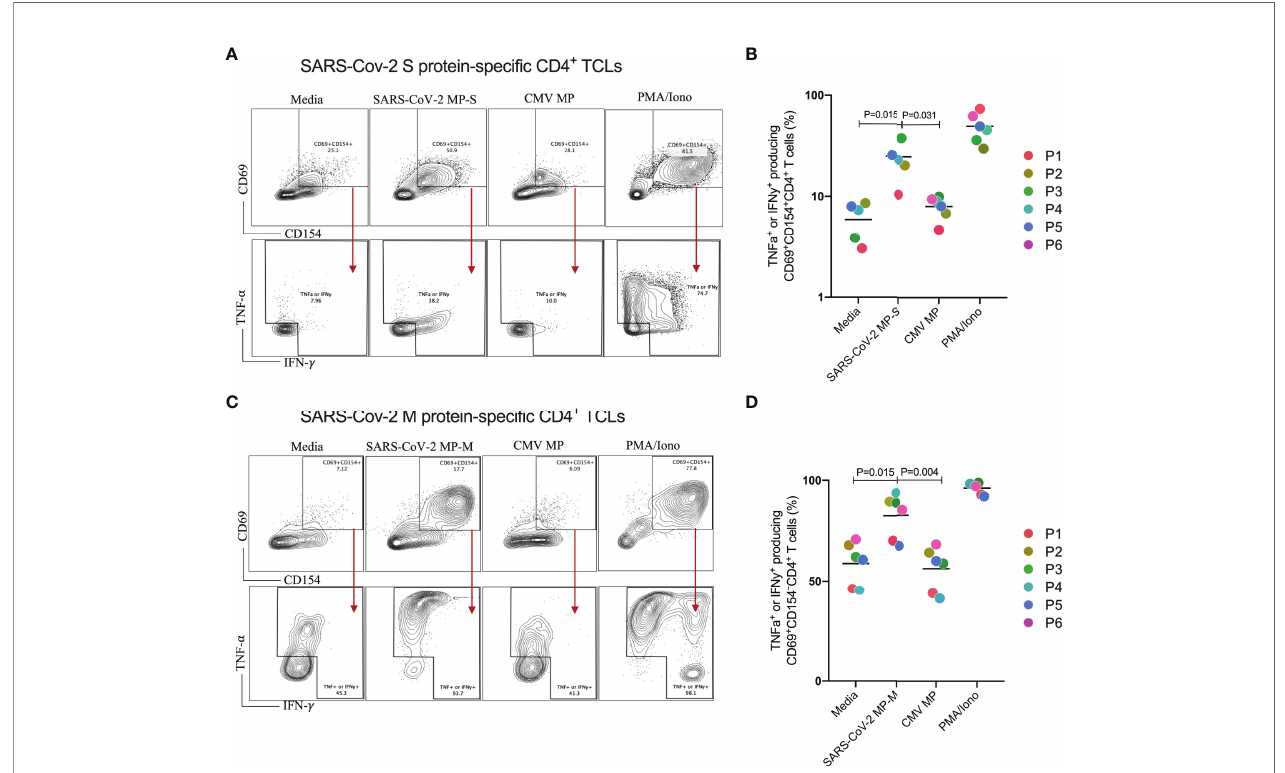
FIGURE 2 | Pro fi ling of SARS-CoV-2 spike (S) and membrane (M) proteins-speci fi c CD4+ T cell line for antigen speci fi city. SARS-Cov-2 spike protein-speci fi c CD4 + TCLs from 6 different donors were cultured in vitro in the absence (media) or in the presence of different stimulation conditions including: either SARS-Cov-2 MP-S (1 µg/mL) or MP- M (1 µg/mL); CMV MP-M (1µg/mL), and PMA/ionomycin (0.5/0.05pg/mL). Panels (A – C) show a representative fl ow cytometric analysis of the of both MP-S or MP-M-speci fi c CD4 + TCLs expressing CD69 + CD154 + and the subsequent antigen-speci fi c cells expressing either IFN- g + or TNF- a + after the different stimulation conditions. Panels B and D reveal the speci fi city and the reactivity of the six MP-S speci fi c CD4 + TCLs (B) or the six MP-M speci fi c CD4 + TCLs (D) demonstrating the frequency of CD69 + CD154 + TCLs producing either IFN- g or TNF- a upon stimulation, in comparison with the unstimulated condition. Each plot represents the CD4 + TCLs from each donor (colored from P1-P6). All differences by Wilcoxon matched-pairs test with P<0.05 are indicated in the